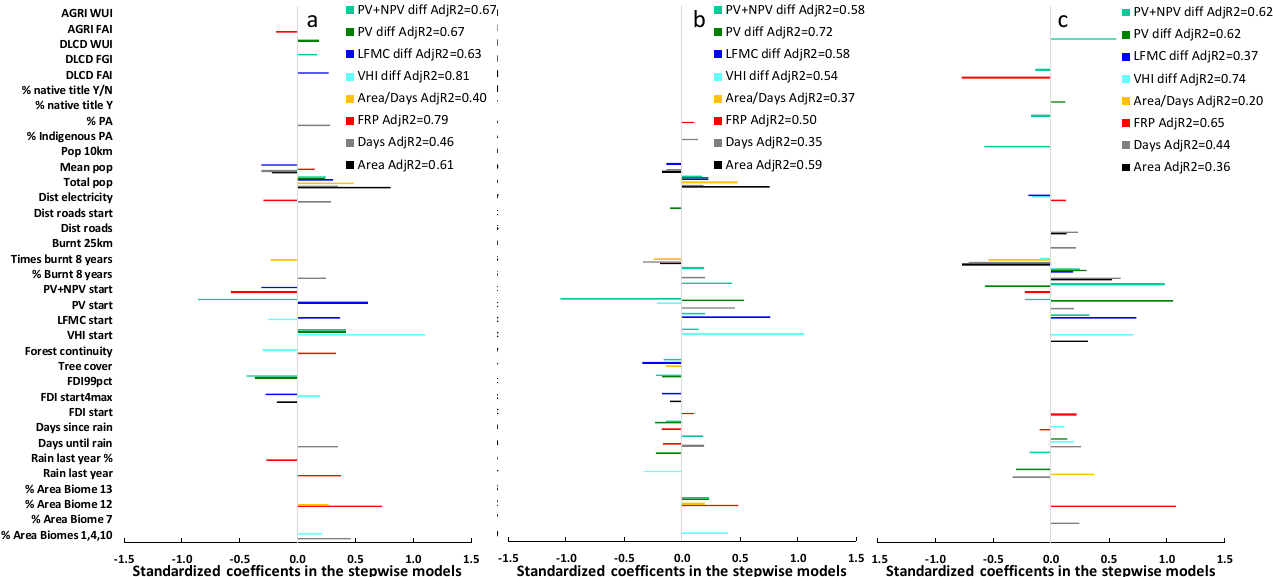
Figure 10. The standardised coefficients of the explanatory variables that were found to be statistically significant in the stepwise regression models for all response variables for ( a ) the Black Summer forest fires in SE Australia ( n = 63); ( b ) the Black Summer forest fires ( n = 205); ( c ) the Black Summer non-forest fires ( n = 186). The models shown in this figure were calculated based on the untransformed variables. The adjusted R 2 values of each of the stepwise models are shown in the legend. The colour of the bars indicates the response variable. Only statistically significant coefficients are shown.